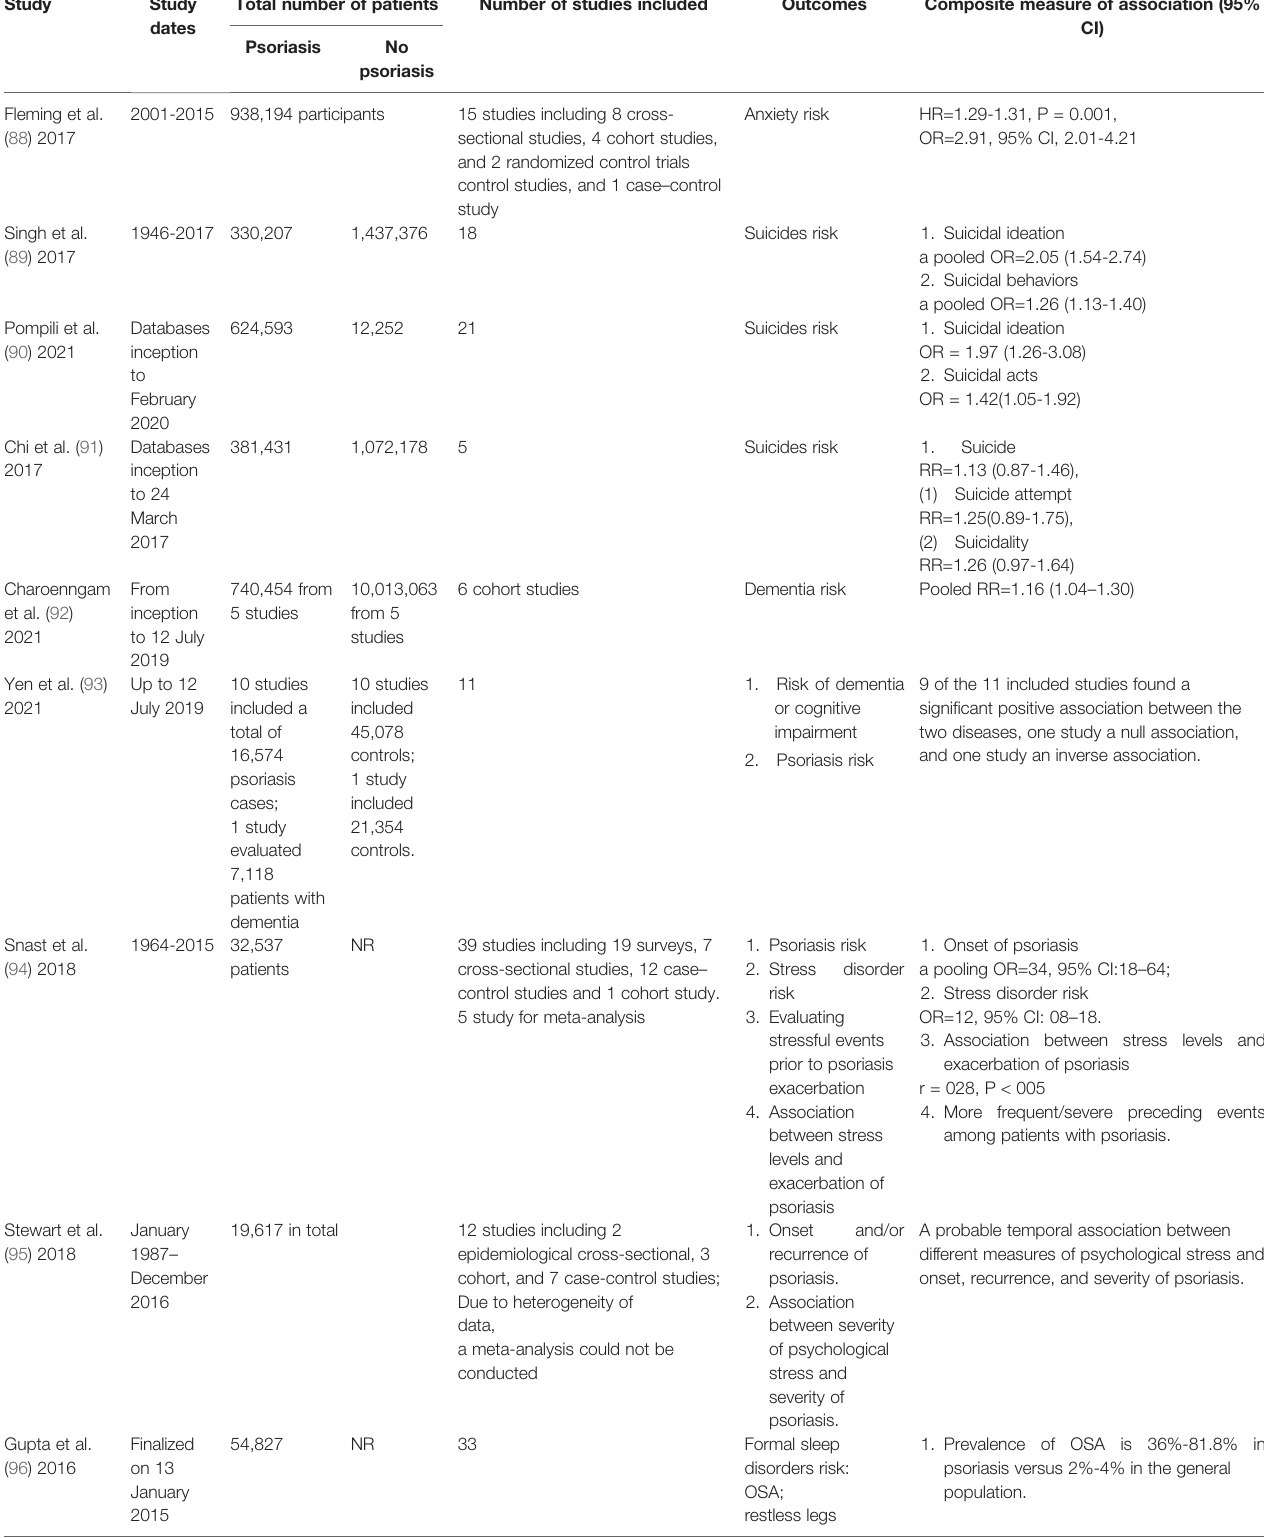
TABLE 3 | Summary of systematic review and meta-analyses assessing the association between psoriasis and mental health diseases.